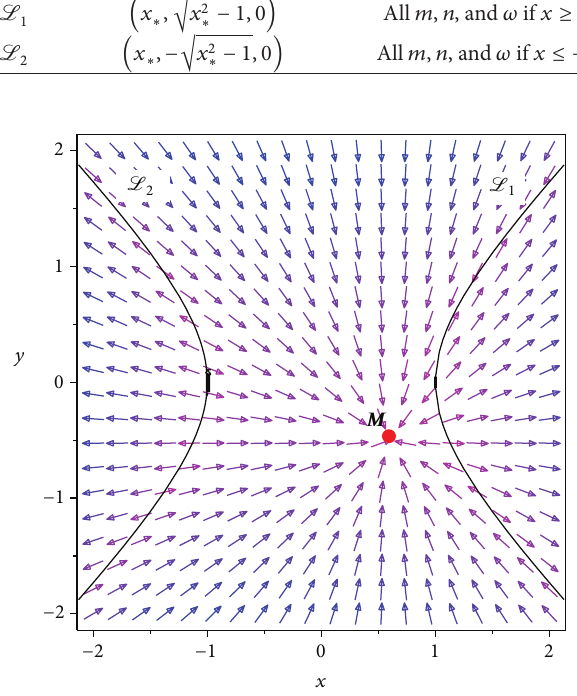
Figure 3: The phase space trajectories of the hybrid chameleon model with 𝑚 = 0.6 , 𝑛 = 0.5 , 𝛽 = 1 , and 𝜔 = 0 . This figure is plotted for the case with 𝑢 = 0 . With these values in the parameters space, the critical lines L 1 and L 2 (the solutions corresponding to the quintessence component’s kinetic energy domination) are repellers (and so unstable solutions). The critical point M (the solution with potential energy domination) is a stable attractor.